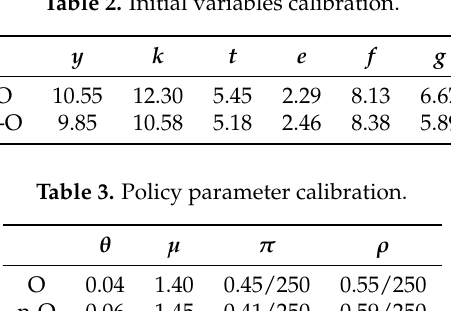
Table 2. Initial variables calibration.